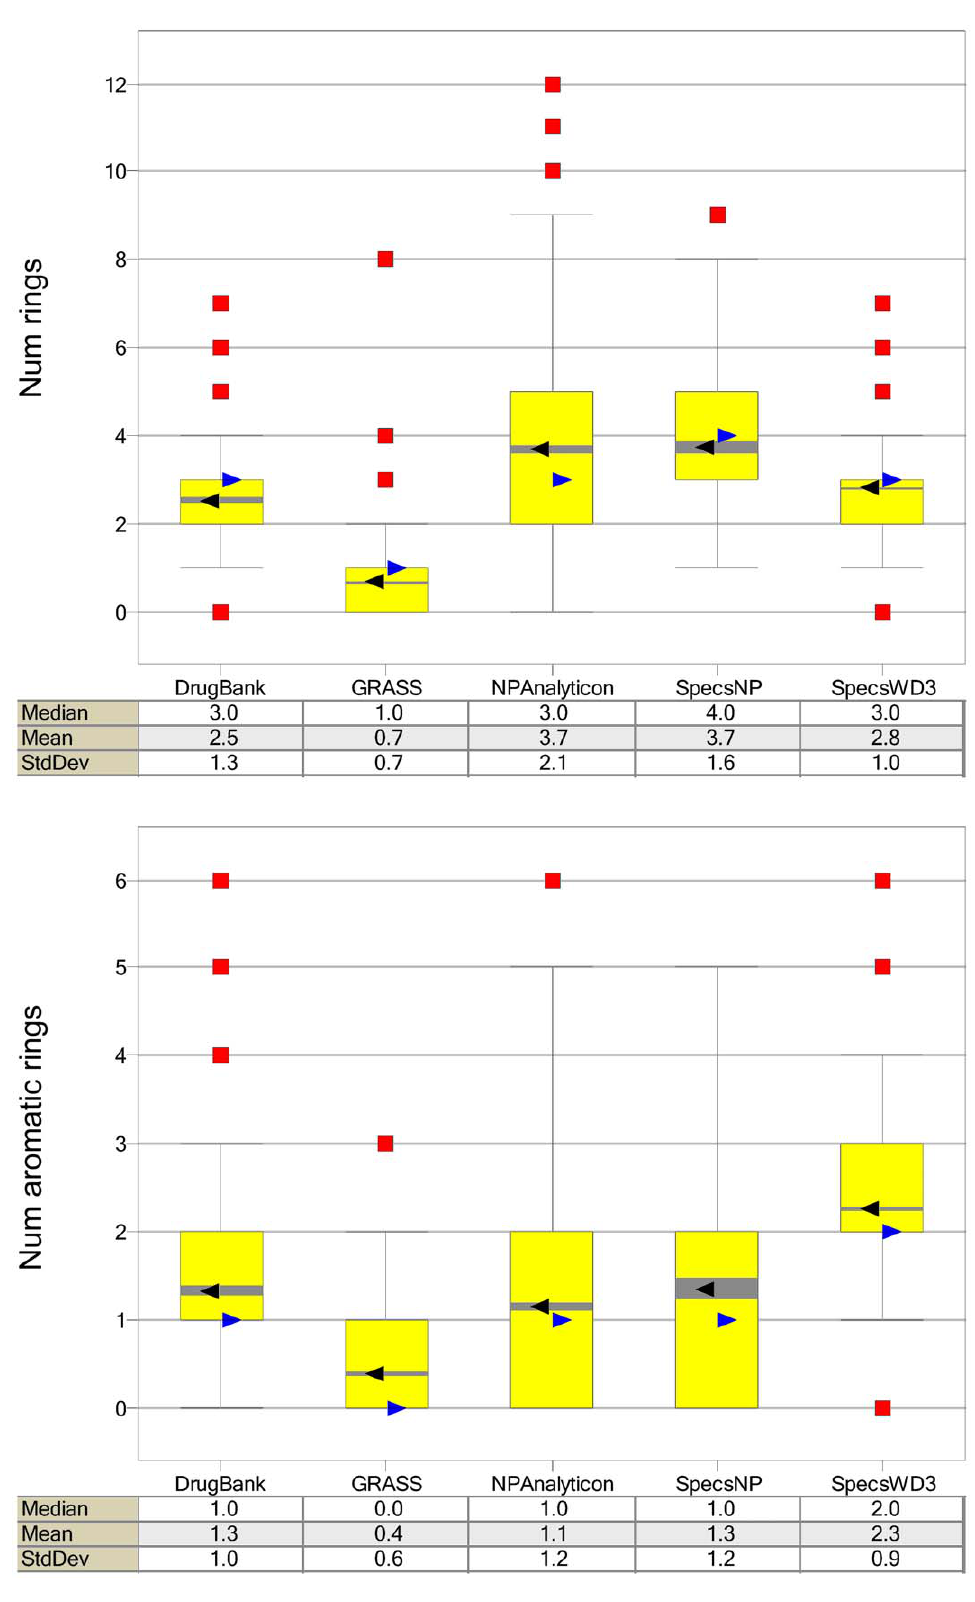
Figure 2. Box-and-whisker plots of the total ring count and aromatic ring count. The symbols and colors in the plots are the same as in Figure 1.